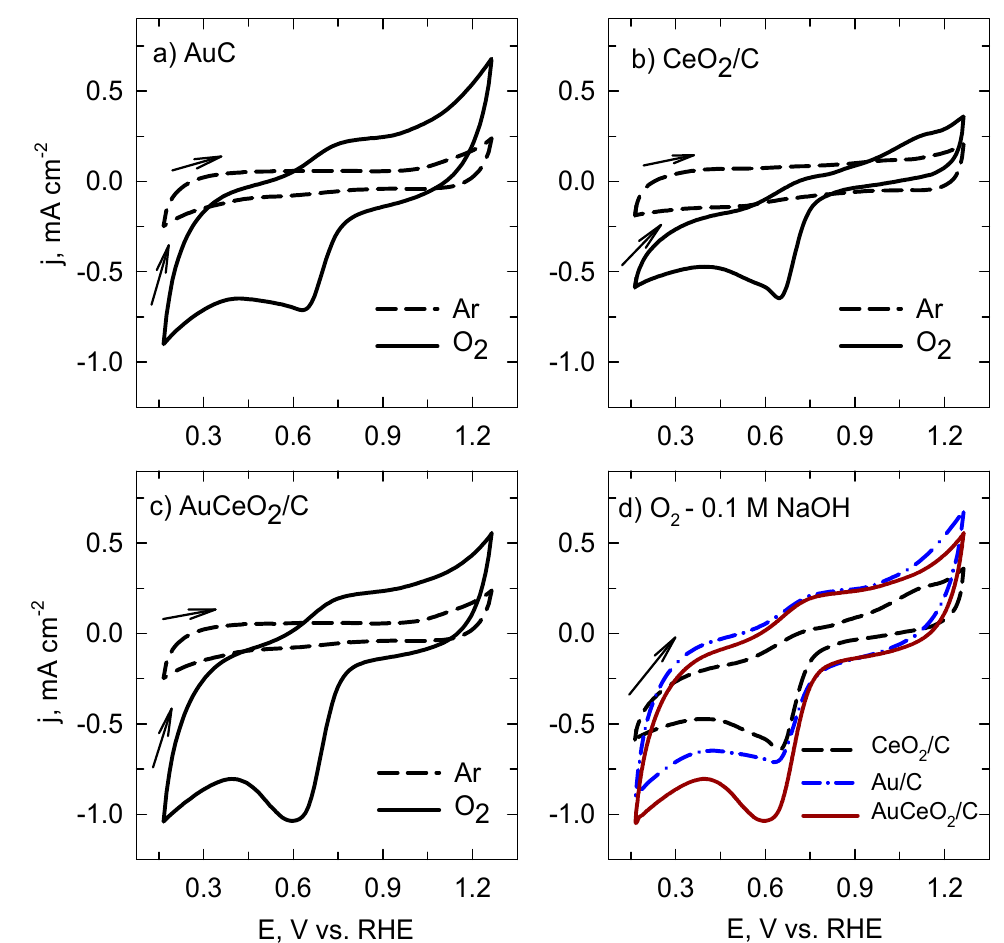
Figure 6. CVs of the investigated catalysts were recorded in an Ar or O 2 -saturated 0.1 M NaOH solution ( a – c ) with a scan rate of 5 mV s − 1 at 0 rpm. Comparison of the CVs of the investigated catalysts recorded in an O 2 -saturated 0.1 M NaOH solution ( d ).